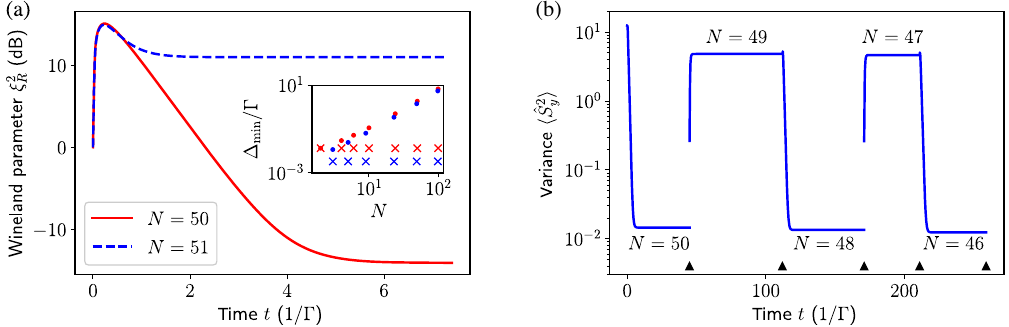
FIG. 4. (a) Time evolution of the coherent spin state j N= 2 ; − N= 2 i under the quantum master equation (2) for even vs odd N with a squeezing parameter r ¼ 2 . 5 . Inset: minimum spectral gap Δ momentum subspace (points) and global minimum evaluated over all angular-momentum subspaces (crosses). (b) Example of how the extreme even-odd sensitivity of the dissipative steady state could be used for sensing. The variance h by the ideal quantum master equation (2) with r ¼ 2 . 5 , starting from the state j N= 2 ; − N= 2 i . The evolution is interrupted at randomly chosen times (black triangles), where a single (randomly chosen) spin is removed from the system. These spin-loss events cause the system to relax to a new steady state, leading to dramatic swings in the value of h used for the y